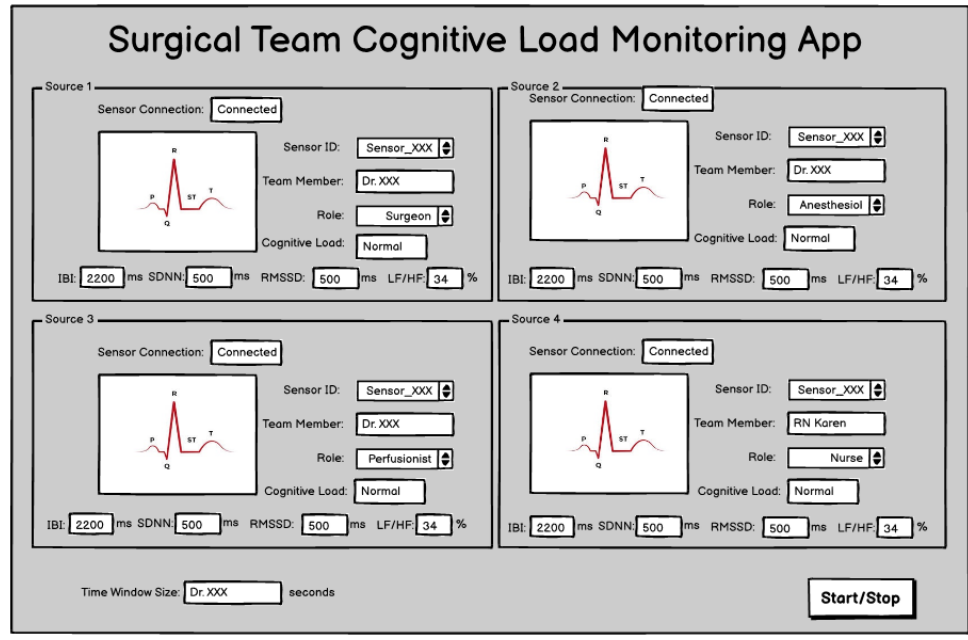
Figure 3. Application Design Wireframe.